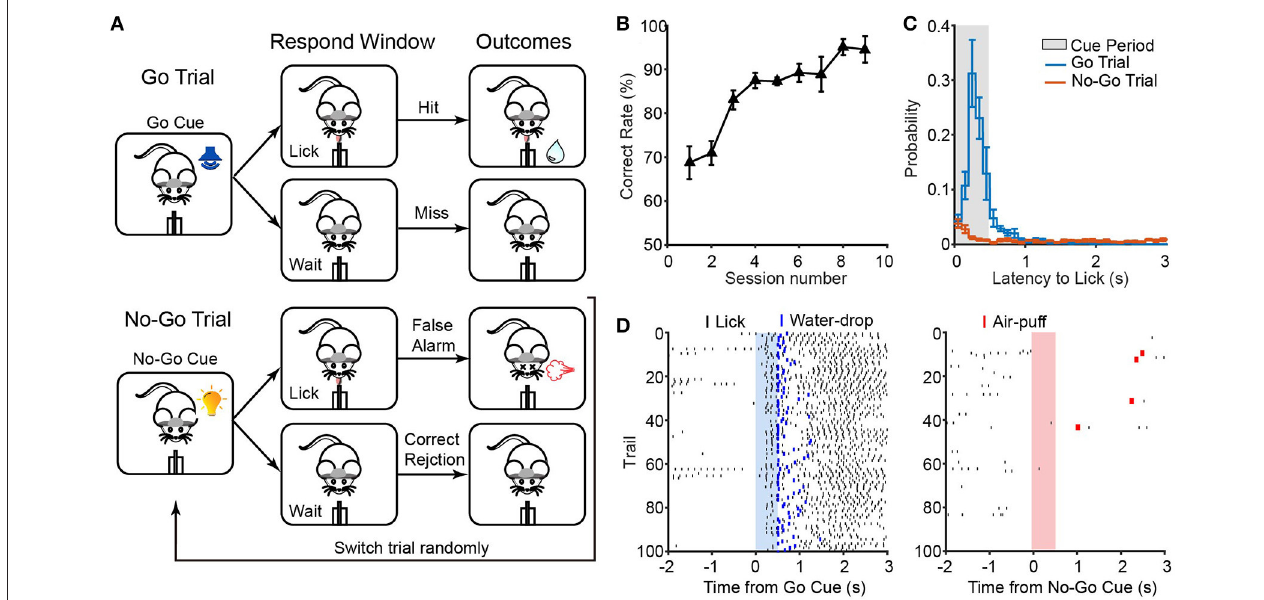
FIGURE 5 | ArControl verification via the Go/No-Go task. (A) Sequence of events in a Go/No-Go task. (B) Learning curve across sessions ( n = 5 mice). (C) Latency from the go/no-go cues onset to the first lick. (D) Licking behavior from a well-trained session aligned with go/no-go cues. Data are mean ±